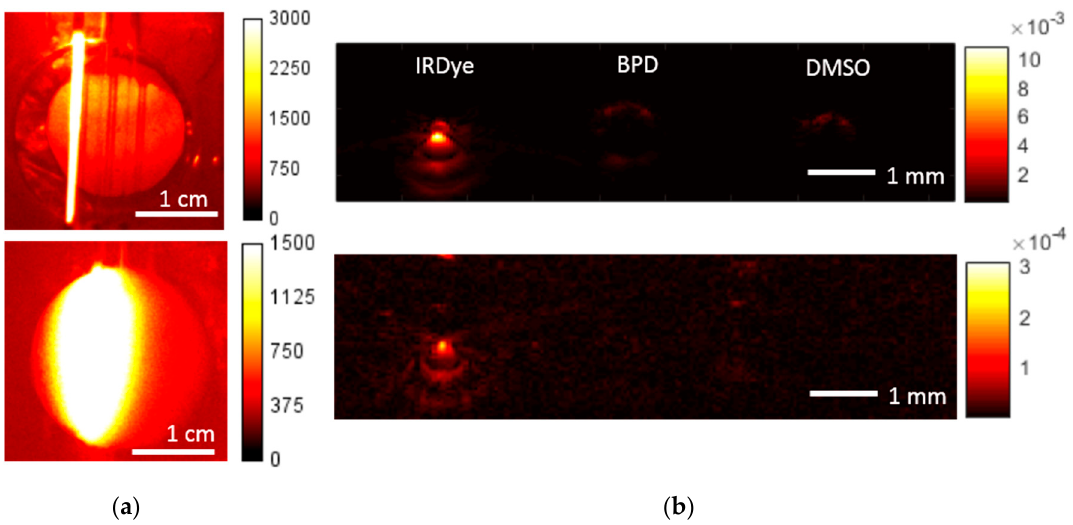
Figure 6. Fluorescence images ( a ) and reconstructed optoacoustic B-scans ( b ) of the water phantom (top) and agar mixture phantom (bottom) for the excitation wavelength of 785 nm.